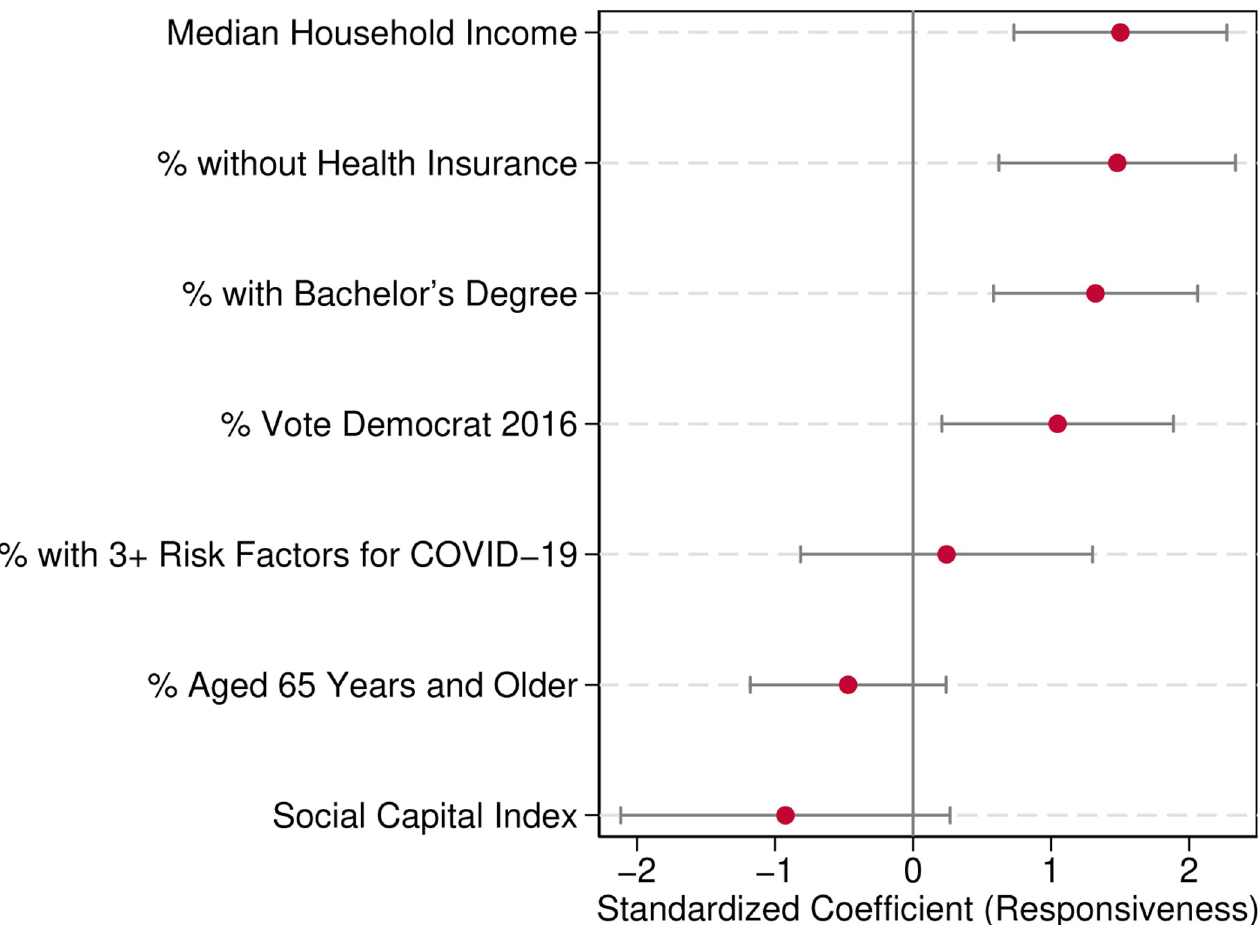
Fig 2. Determinants of responsiveness to COVID-19. Notes : This figure plots estimates of responsiveness to new deaths from Table 3. See corresponding footnotes for details.